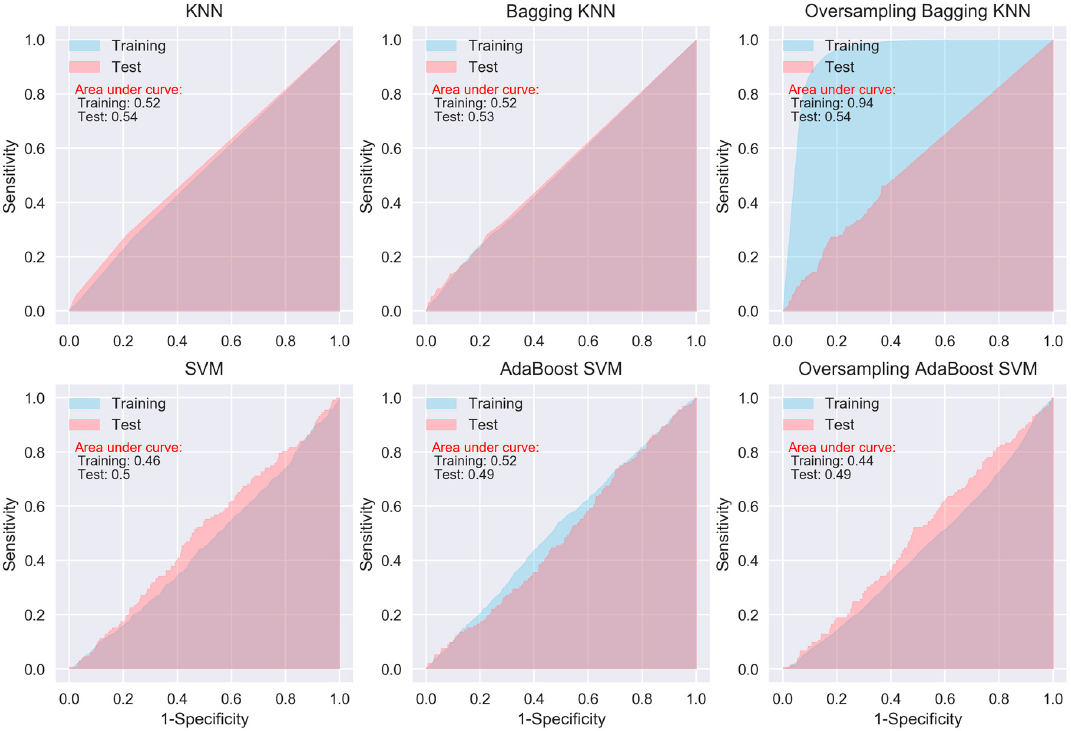
Figure 4. ROC curves of KNN and SVM.